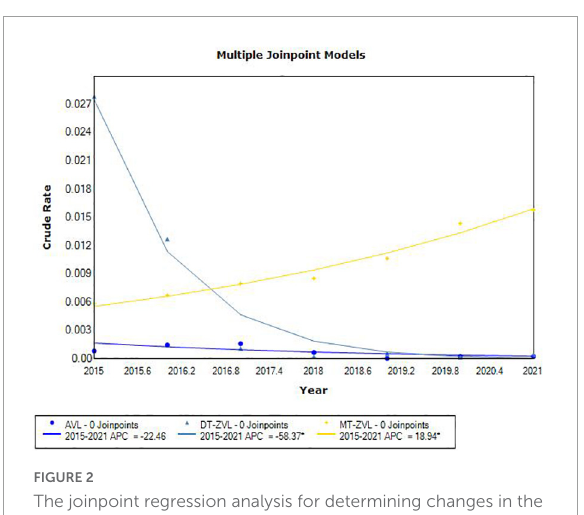
FIGURE2 The joinpoint regression analysis for determining changes in the trend of visceral leishmaniasis incidence in China from 2015 to